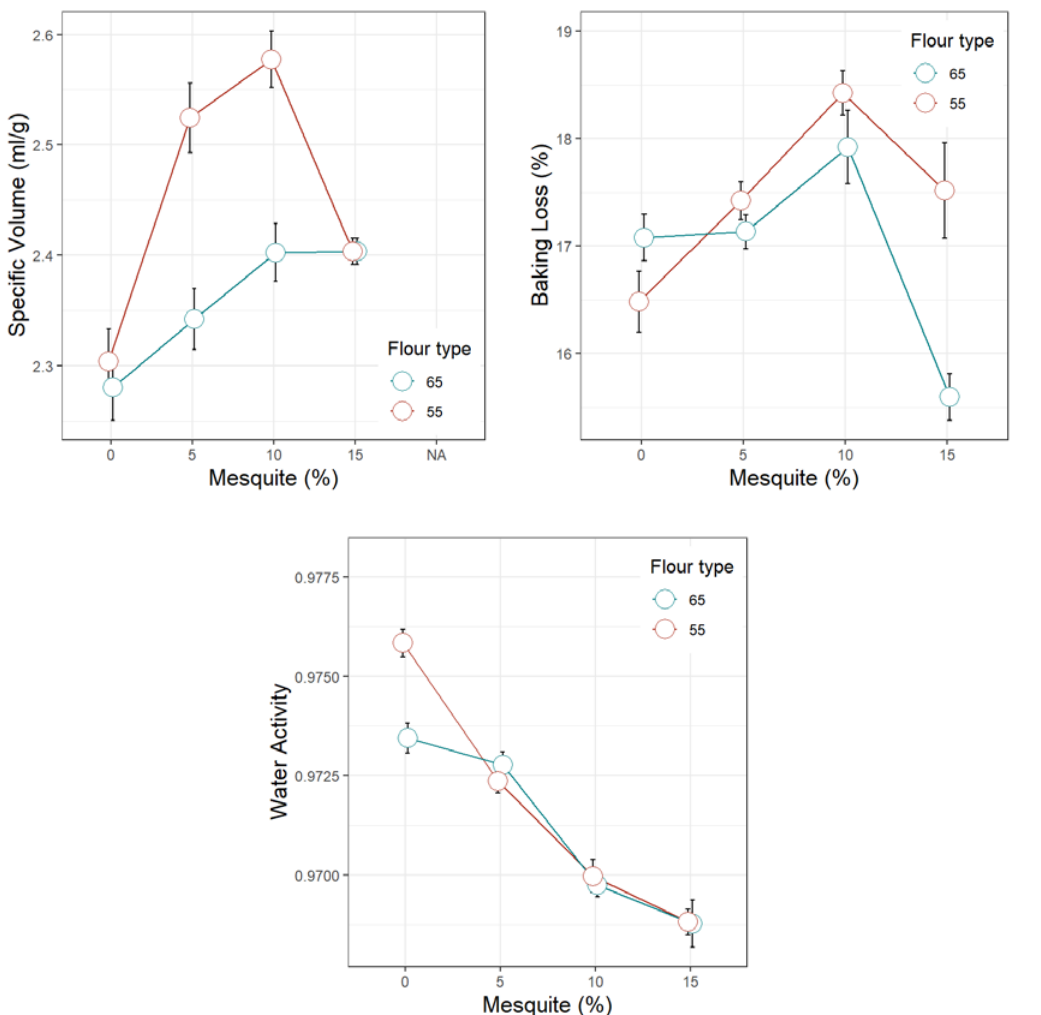
Figure 3. Loaf gravimetric properties and crumb water activity of bread made of wheat flour type 65 or 55 partially replaced with mesquite pod flour.